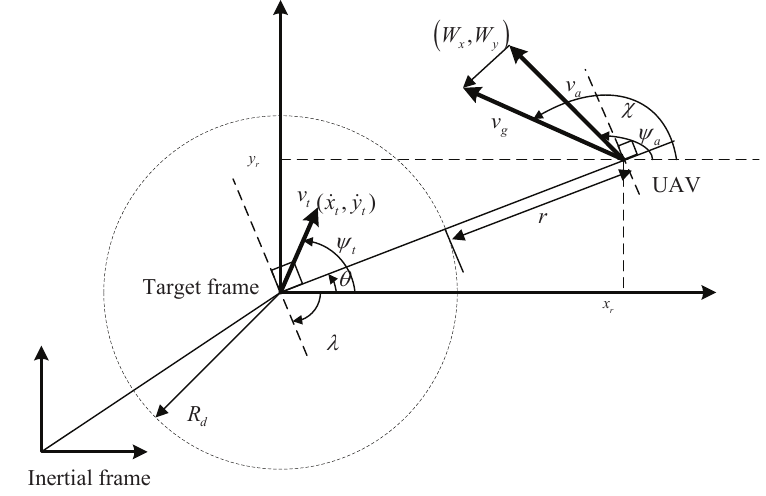
Figure 1. Tracking geometry between the target and unmanned aerial vehicle